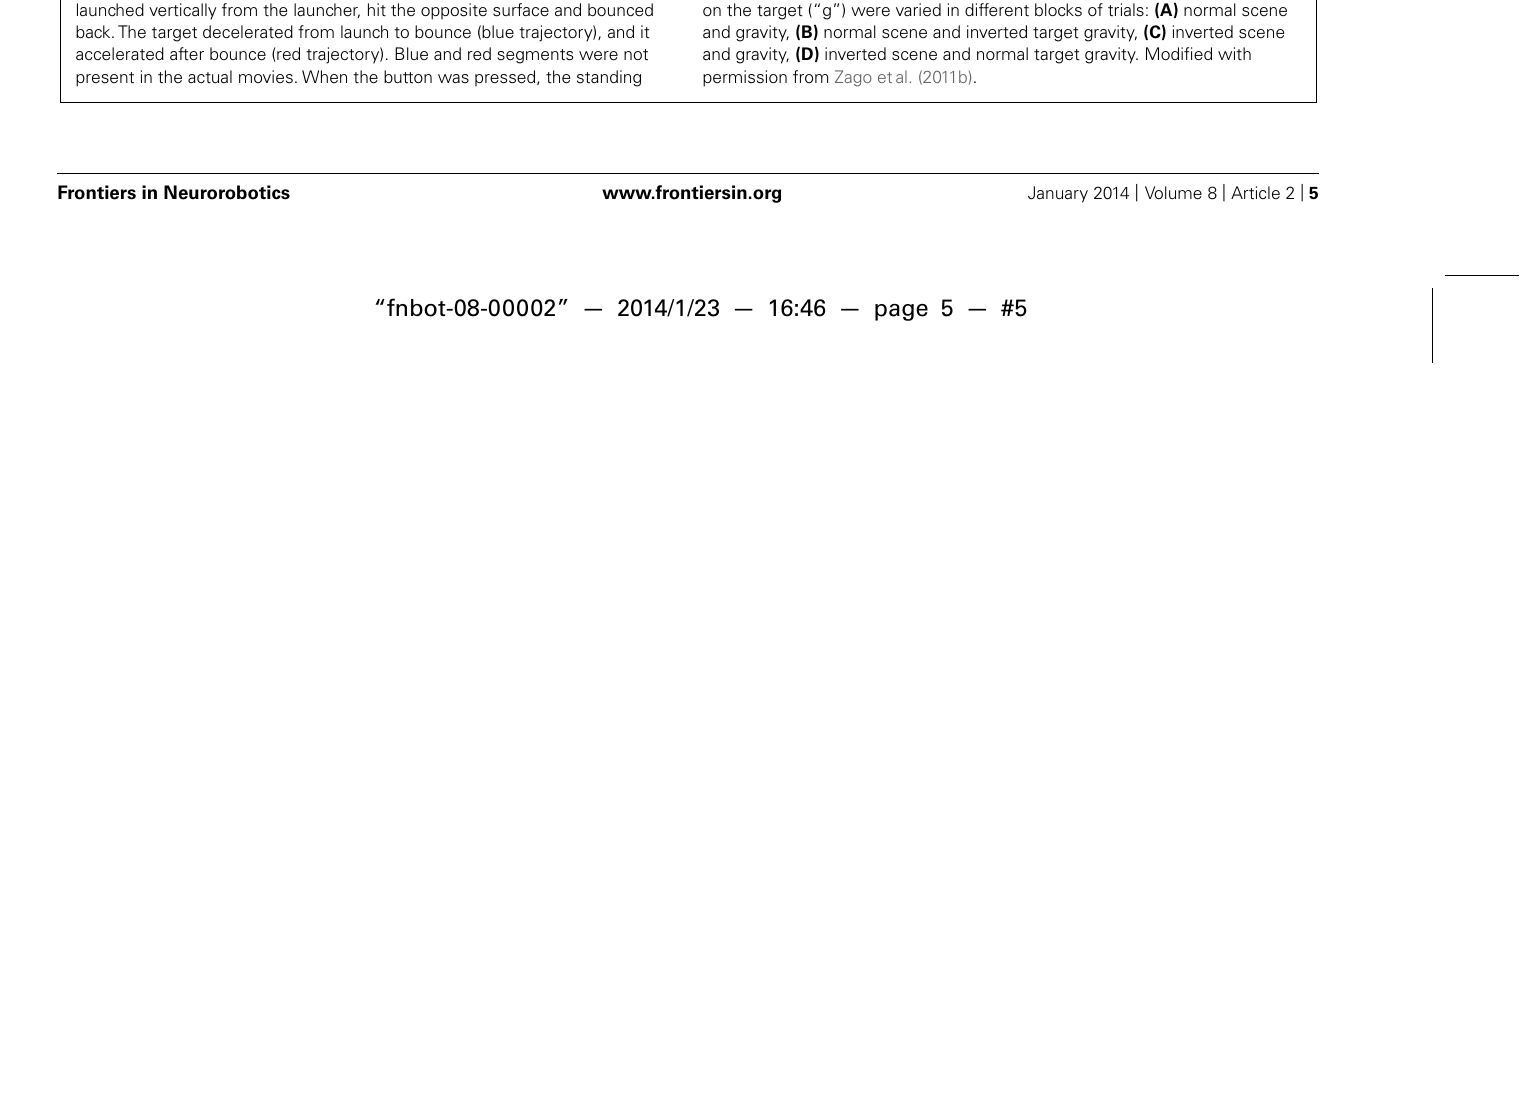
FIGURE 2 | Scenes displayed in the manipulation of visual congruence between background and gravity orientation. The target ball was launched vertically from the launcher, hit the opposite surface and bounced back.The target decelerated from launch to bounce (blue trajectory), and it accelerated after bounce (red trajectory). Blue and red segments were not present in the actual movies.When the button was pressed, the standing